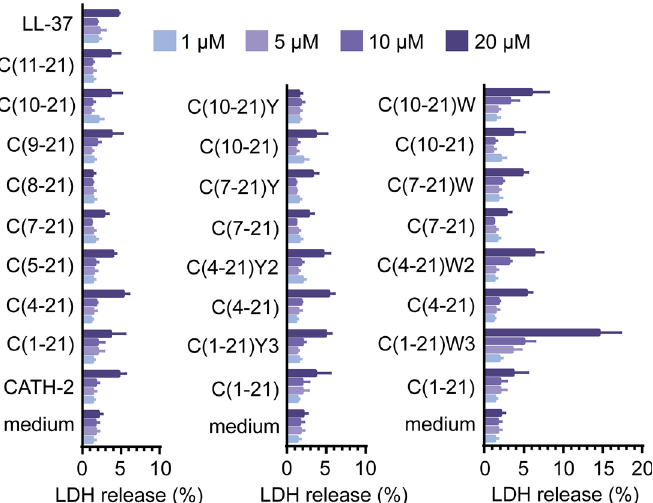
Fig 2. Peptide-induced LDH release from HD11 cells. The percentage of lactate dehydrogenase (LDH) released from HD11 cells during 24 h exposure to medium containing CATH2 derived peptides (1 – 20 μ M). Shown are means ± SEM for at least 3 independent